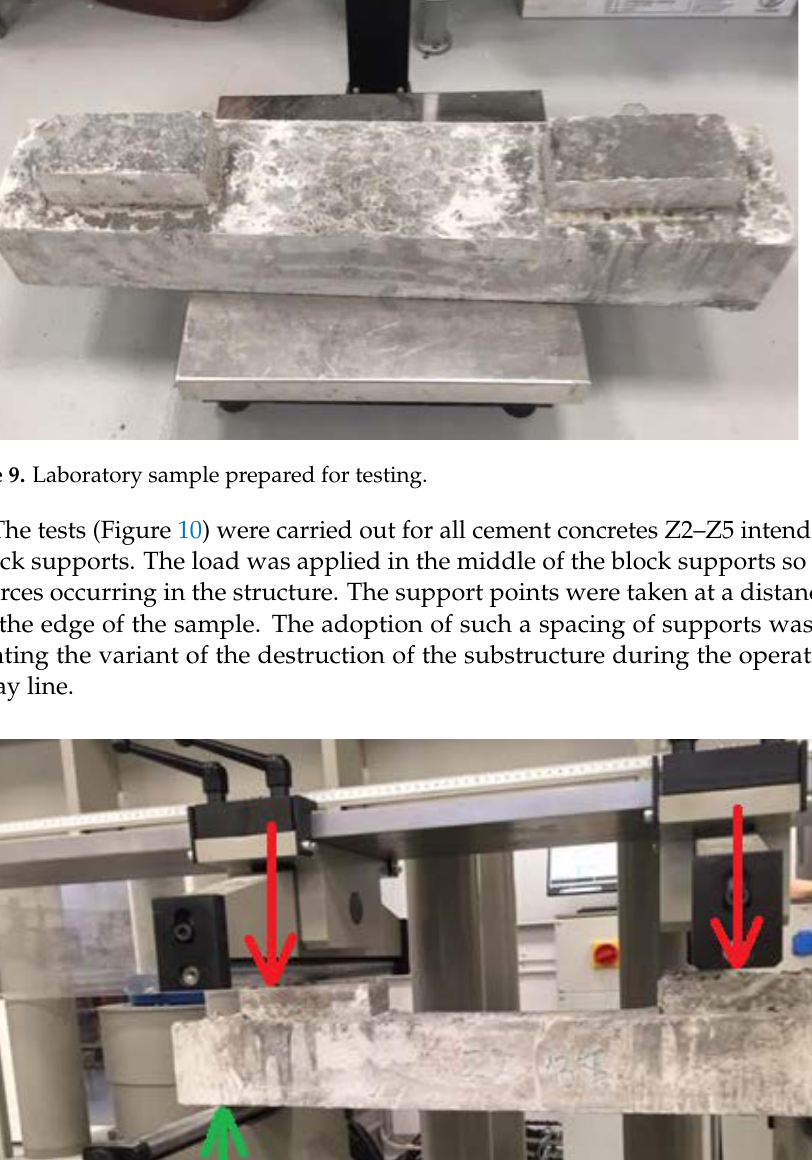
Figure 10. Sample in the test machine (in a model: red arrows—forces generated by the vehicle wheel, green arrows—reaction forces generated by the machine support).